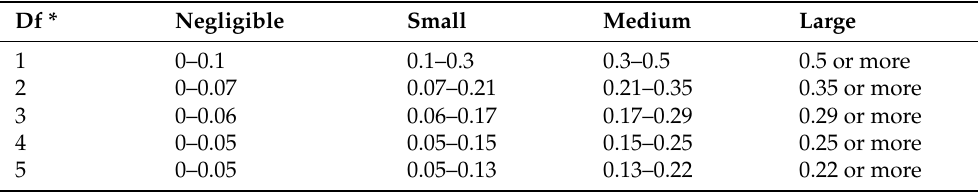
Table 1. The guidelines according to Cohen